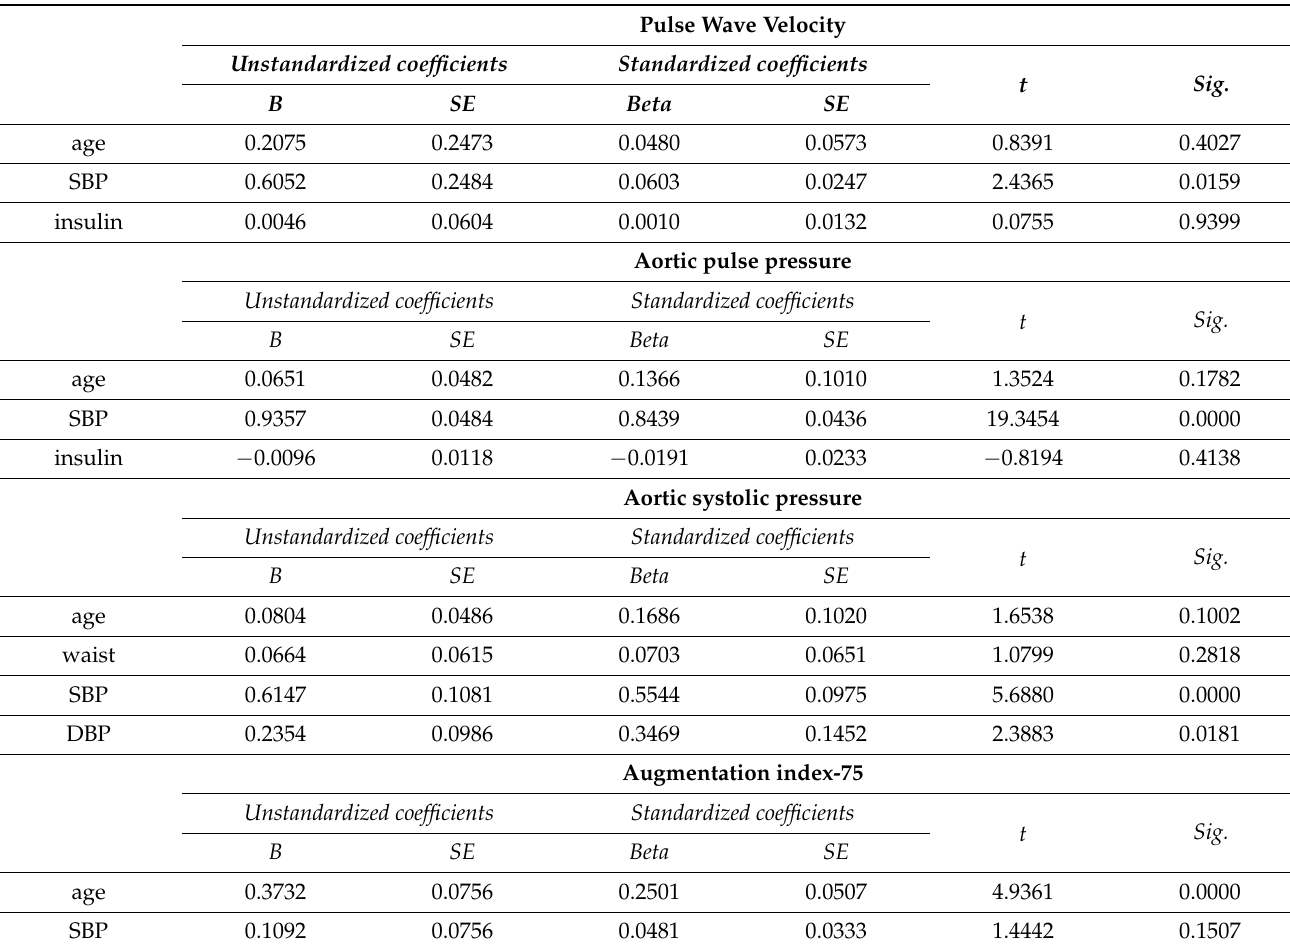
Table 3. Multiple regression analyses of independent factors affecting selected vascular damage markers as dependent